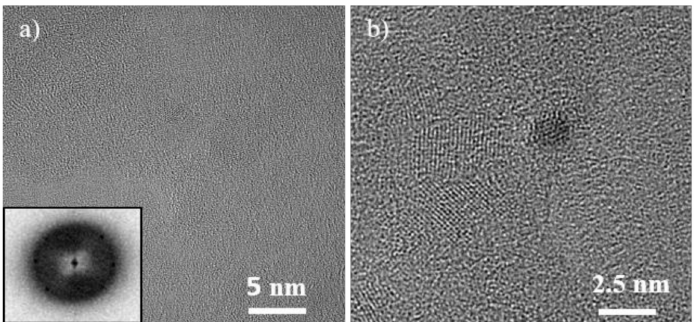
Figure 3. ( a ) TEM image of HiPIMS sputtered Cr-Mn-Fe-Co-Ni NPs transferred on a carbon-coated gold grid from the IL and its corresponding FFT (shown as an inset). ( b ) HRTEM shows bcc lattice planes within the NPs.